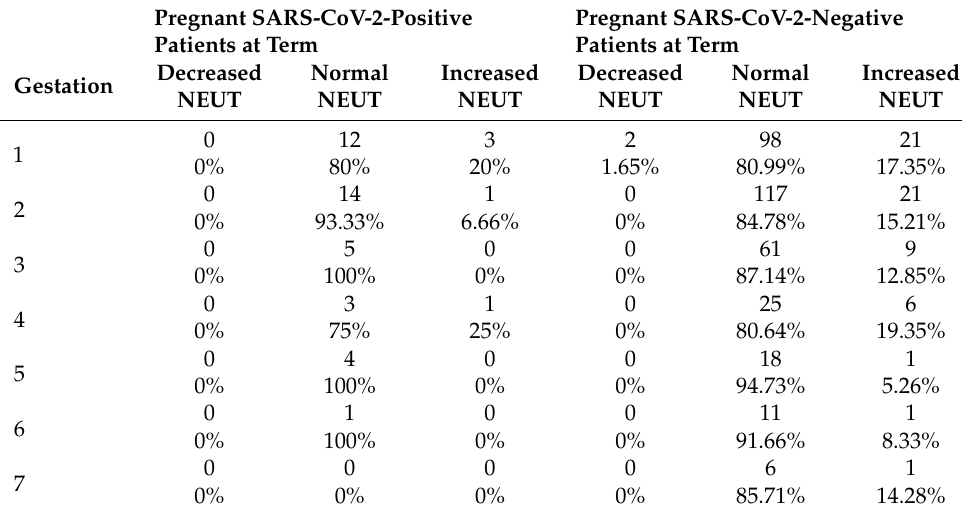
Table 10. Number and percentage of pregnant patients with a normal, increased, and decreased number of neutrophils, as regards